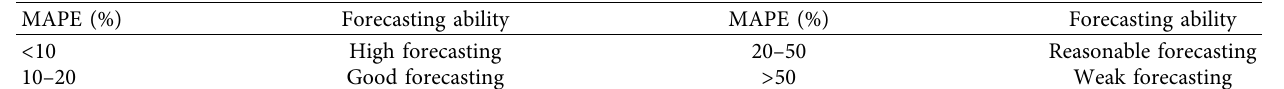
Figure 2: The flowchart of the GM(1,1) model with improved background value. Table 2: The MAPE criterion for model examination [34].